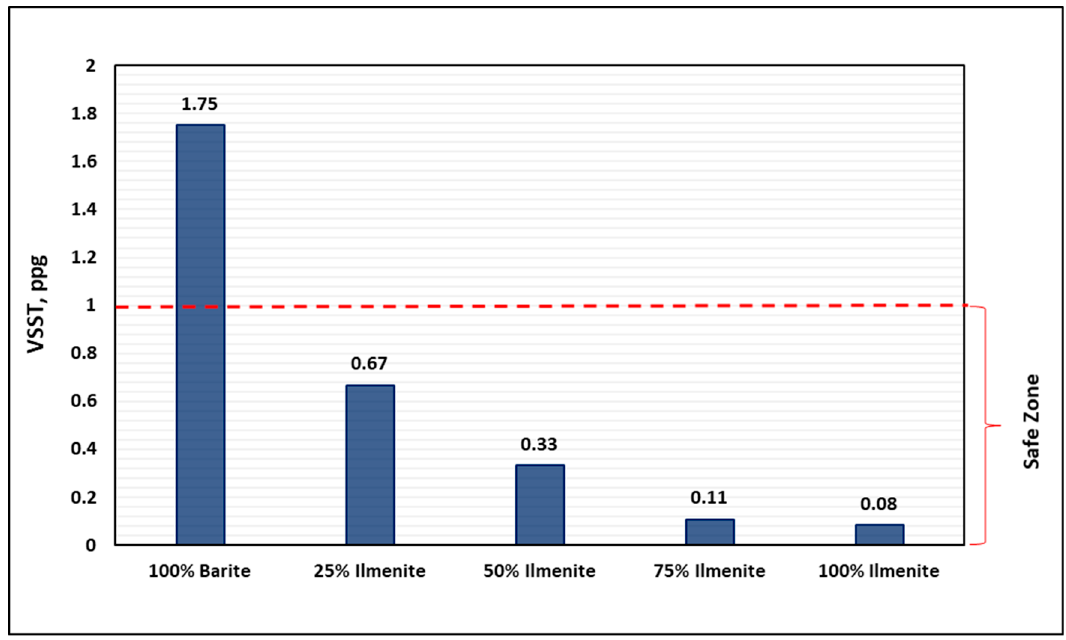
Materials 2019 , 11 , x FOR PEER REVIEW ff ect of ilmenite on drilling fluid sag tendency under dynamic conditions (120 ◦ F). Figure 6. Effect of ilmenite on drilling fluid sag tendency under dynamic conditions (120 °F). Figure 6. E